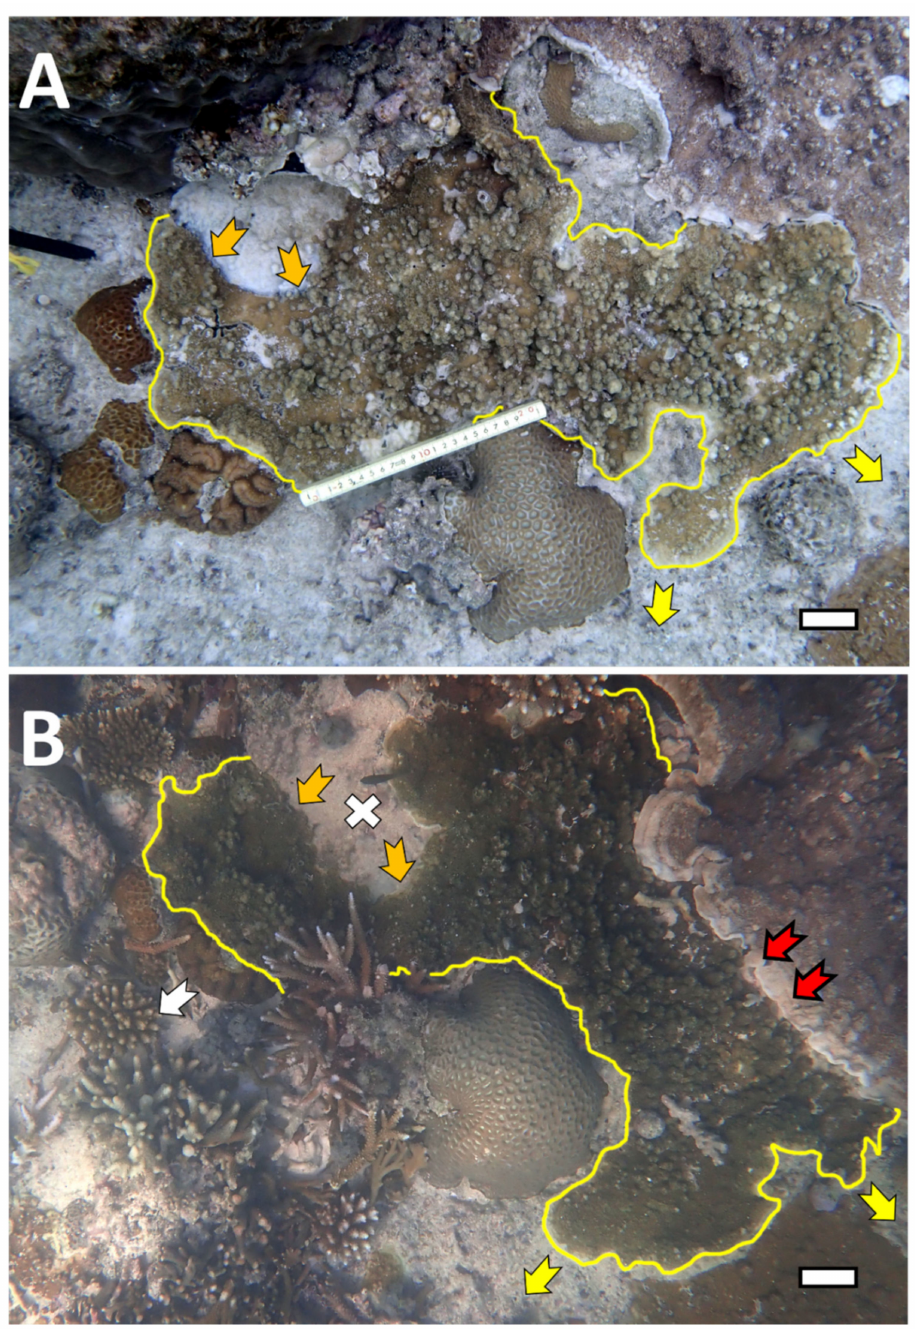
Figure 9. Encrusting Montipora survives BBD ( A ) 20 July 2018, orange arrows show BBD, yellow arrows show colony growth direction. ( B ) 7 September 2020, white X shows no tissue, BBD absent (orange arrows), yellow arrows indicate growth direction, white arrow indicates Montipora outcom- petes nearby corals, red arrows indicate nearby healthy Montipora competing for growth. Scale bars: 5 cm. Photograph: Rocktim Ramen